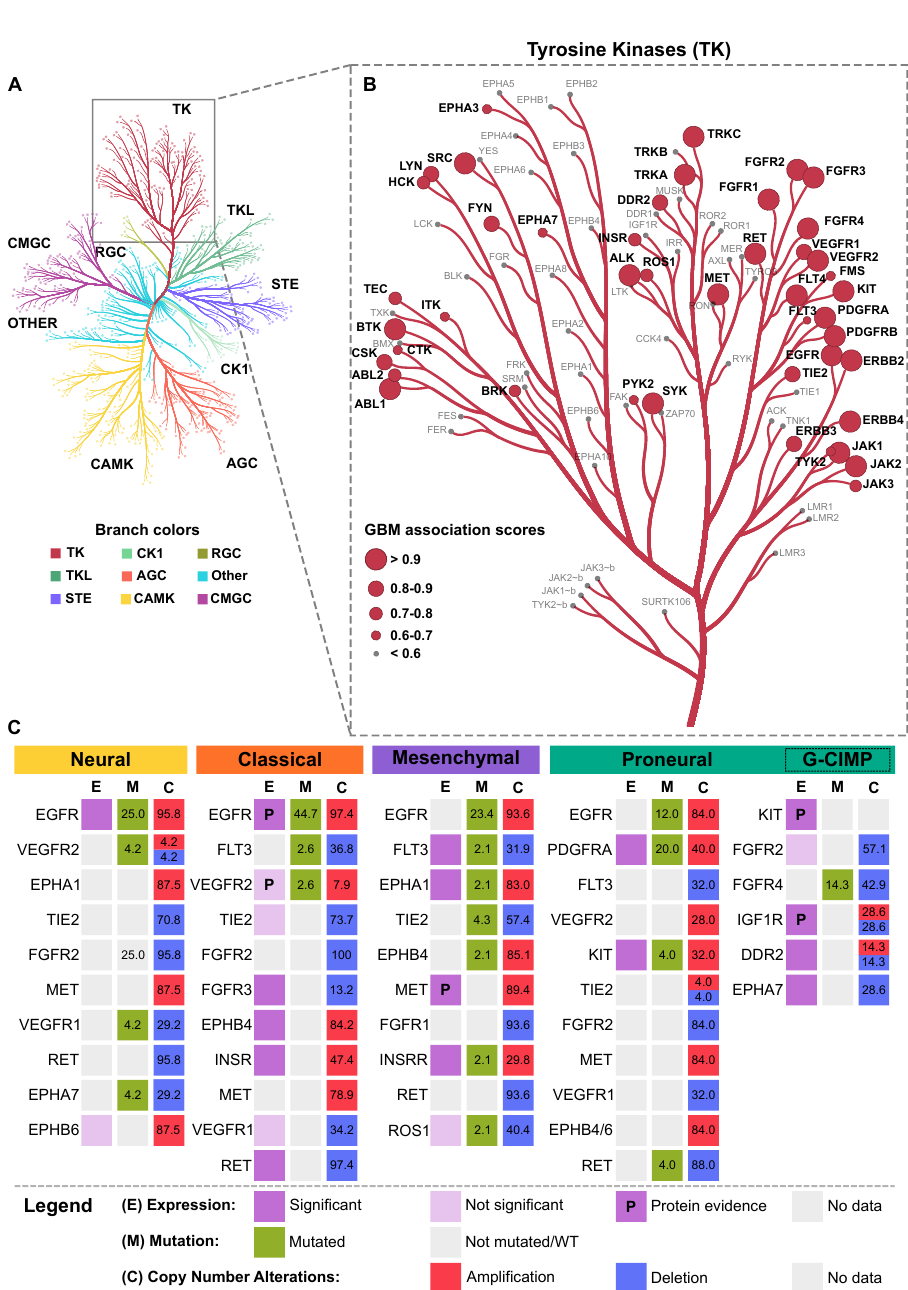
Receptor guanylate cyclases; CMGC, CDK/MAPK/GSK-3/CDK-like kinases. ( C )